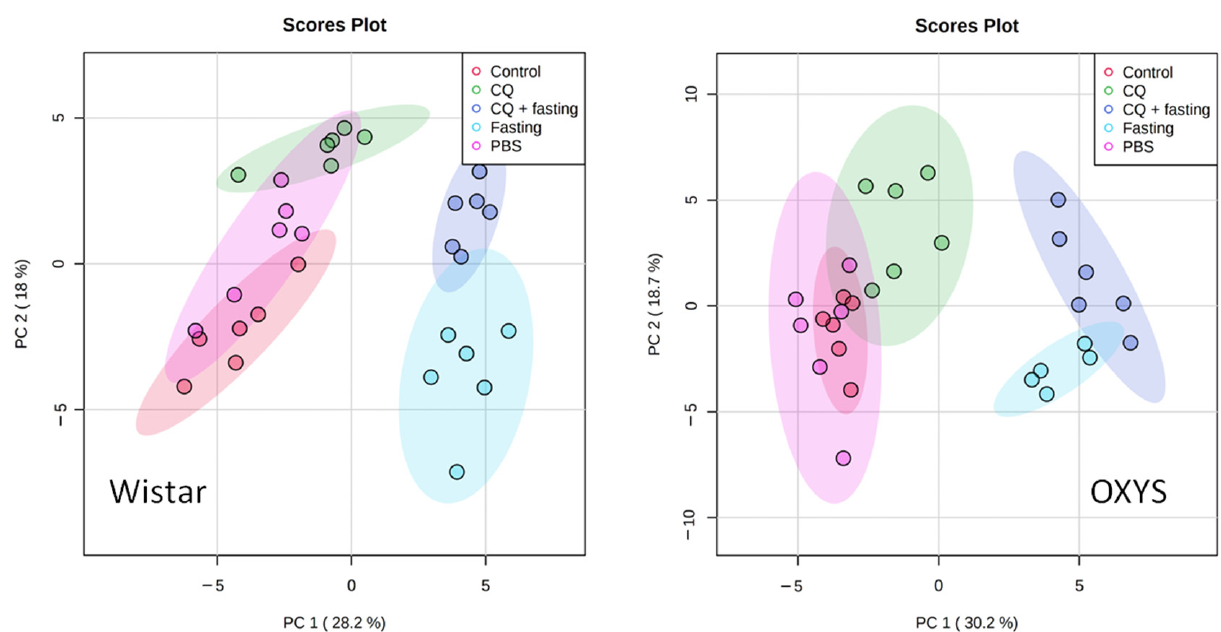
Figure 2. PCA score plots for concentration of aqueous metabolites extracted from blood serum of two rat strains. The groups are presented according to experimental design (Figure 1, Table S4).